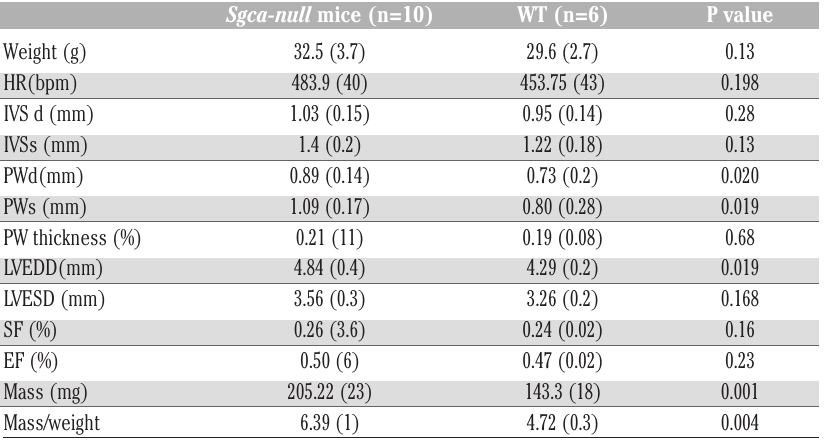
Table 1. Comparison of Wild Type (WT) mice and sgca-null mice echocardiography’s parameters at 13 months of age.